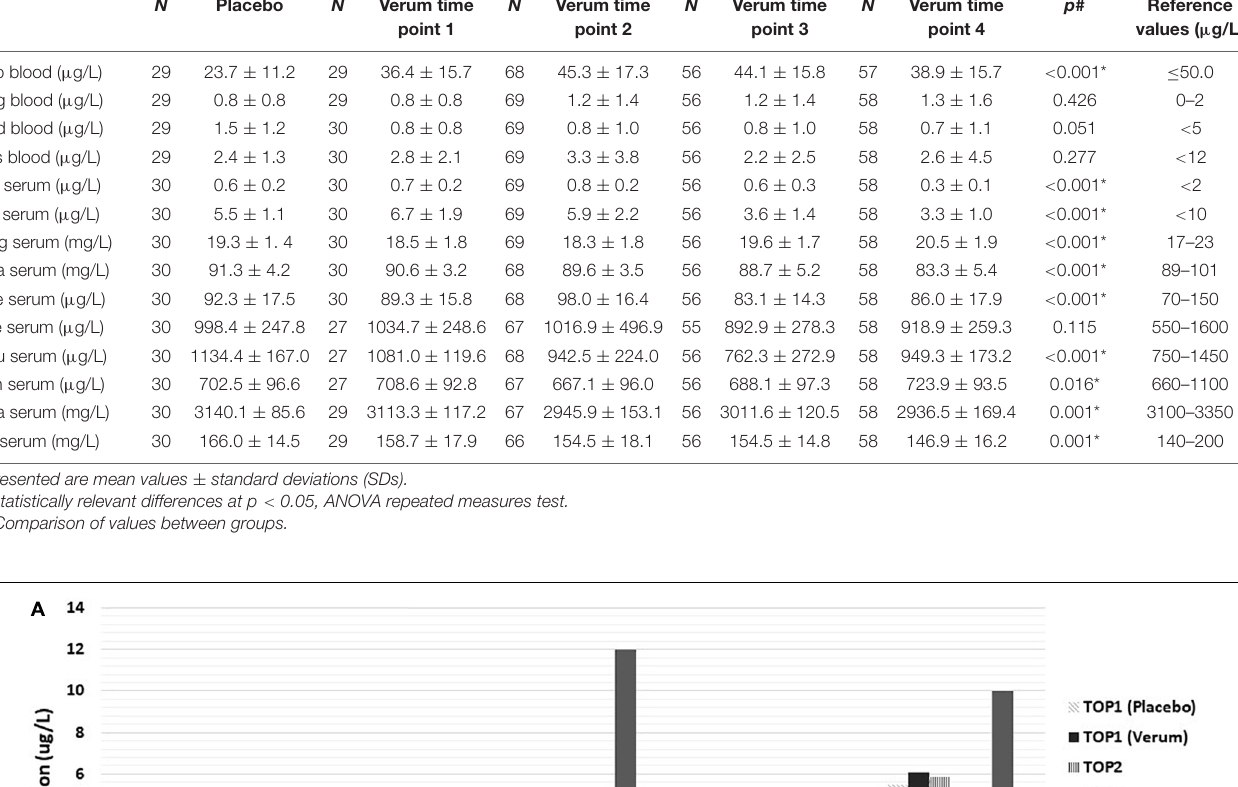
TABLE 5 | Concentrations of selected metals measured in the TOP study in Placebo, Verum 1Y (time point 1), Verum 2Y (time point 2), Verum 3Y (time point 3), and Verum 4Y (time point 4) in comparison with each other. N Placebo